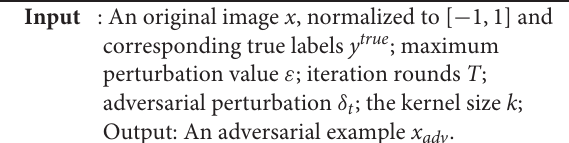
Algorithm 1: REI-FGSM Algorithm 2: